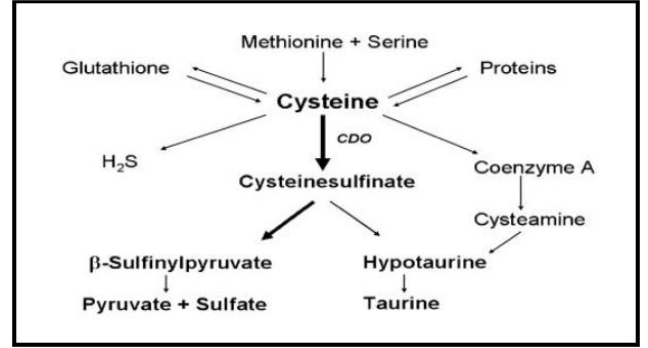
Figure 2. Summary of cysteine metabolism [8].